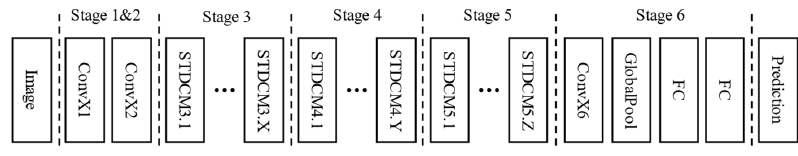
Figure 6. STDC network structure.